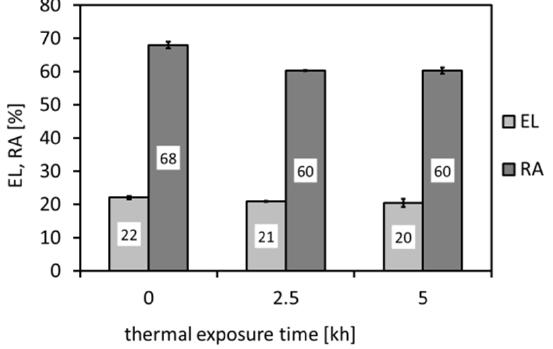
Figure 7. Effect of thermal exposure time at 600 °C on deformation properties of investigated P92 steel.